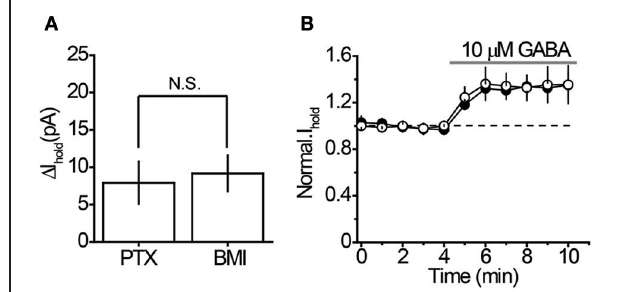
FIGURE 3 | Characteristics of the tonic GABA A current in bafilomycin A1-treated slices. (A) 100 μ M picrotoxin (PTX, n = 6) and 25 μ M bicuculline (BMI, n = 5) revealed similar tonic GABA A current in CA1 interneurons of bafilomycin A1-treated slices. (B) Sensitivity of I hold to exogenous GABA (10 μ M) in control ( n = 6) and bafilomycin A1-treated slices ( n = 7). Black circles — I hold in control slices, white circles — I hold in bafilomycin A1-treated slices normalized to corresponding baseline values (dashed line). Gray line —GABA application. N.S. P > 0 . 05, unpaired t -test.